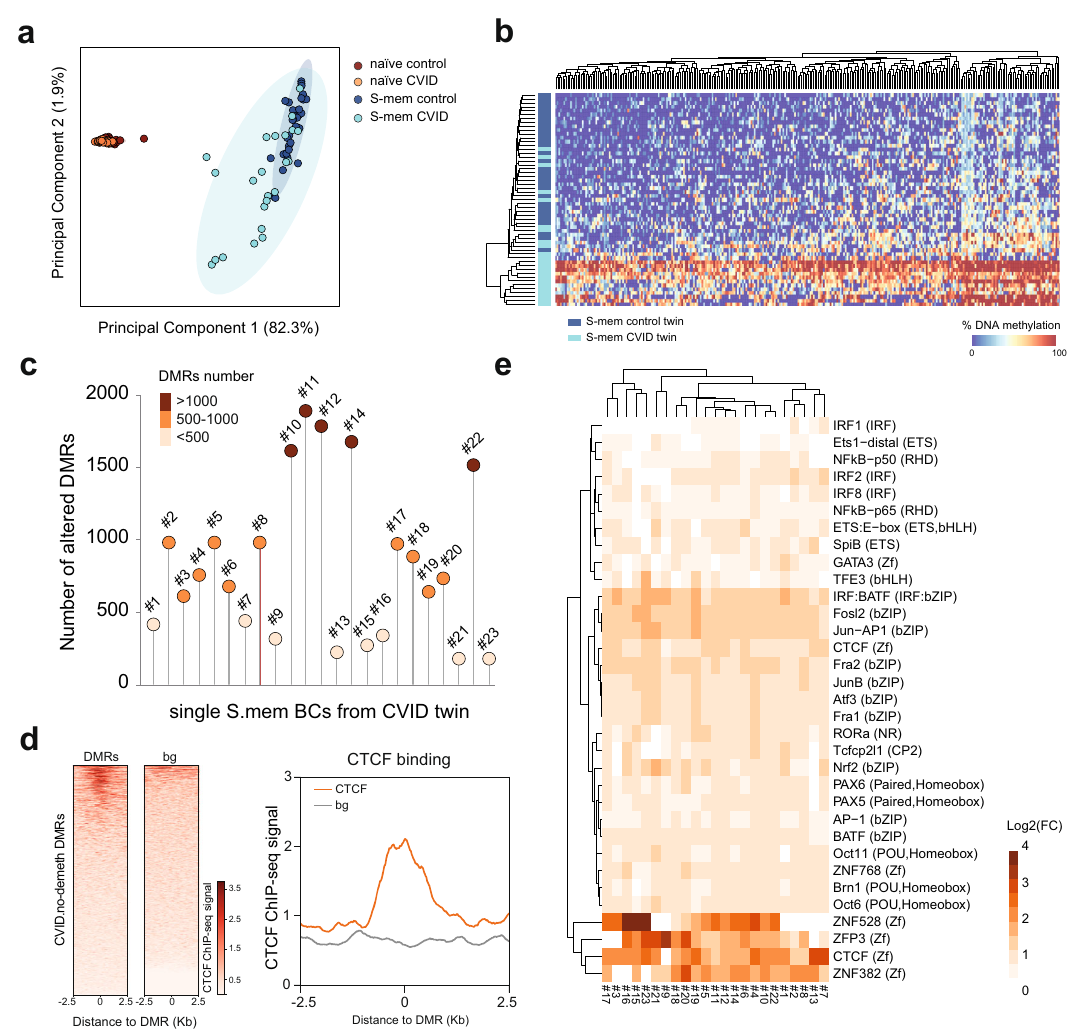
Fig. 2 Heterogeneous DNA methylation alterations in CVID S-mem B cells. a Dot plot showing principal component analysis based on the DMRs at the single-cell level of naïve and S-mem B cells in the control and CVID twins. The elliptical shadows correspond to the con fi dence interval (90% CI) for each subpopulation. b Heatmap representing the DNA methylation percentage of the 300 most variable CVID.no-demeth DMRs at the single-cell level. Dark blue samples correspond to S-mem B cells from the control twin; light blue samples correspond to S-mem B cells from the CVID twin. c Plot showing the number of altered hypomethylated DMRs for each individual S-mem B cell for the entire set of cells analyzed at the single-cell level in the CVID twin. d Heatmap and histogram depicting CTCF binding signal in human primary B cells at CVID.no-demeth DMRs ± 2.5 Kb fl anking regions. CTCF binding data was obtained from publicly-available ChIP-seq dataset (see Methods). e Heatmap representing the log 2 (FC) enrichment for several TF binding motifs at the single-cell level over the altered hypomethylated DMRs in S-mem B cells from the CVID twin. Source data for panels in this fi gure are provided in the Source Data Fig. 2 fi